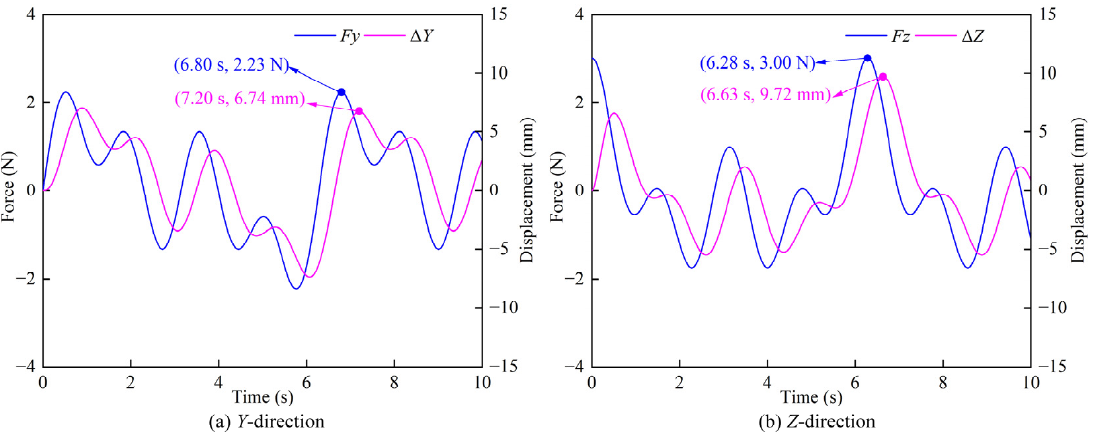
Figure 8. The comparison of the contact force and the position correction amount in different directions ( a ) Y -direction; ( b ) Z -direction.